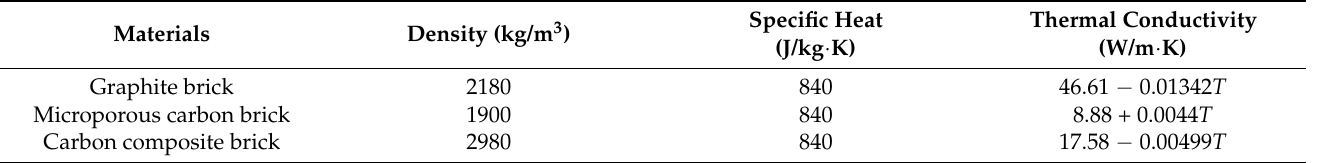
Figure 2. The hearth structure of the BF. ( a ) design structure of hearth lining. ( b ) hearth erosion profile.